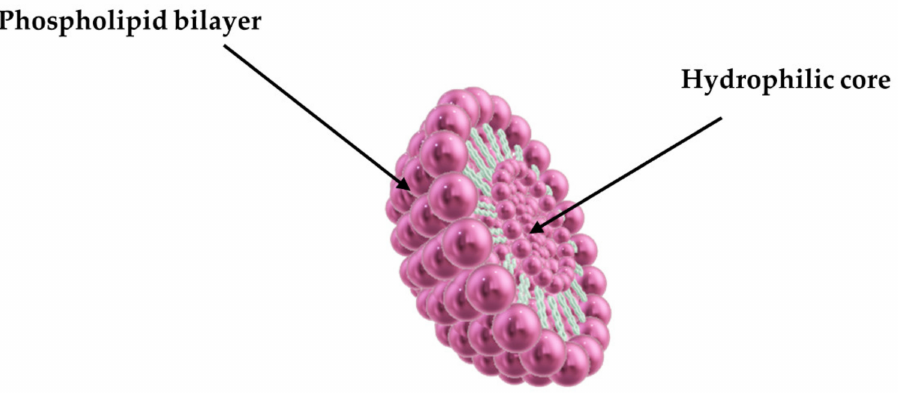
Figure 4. Schematic illustration of a conventional